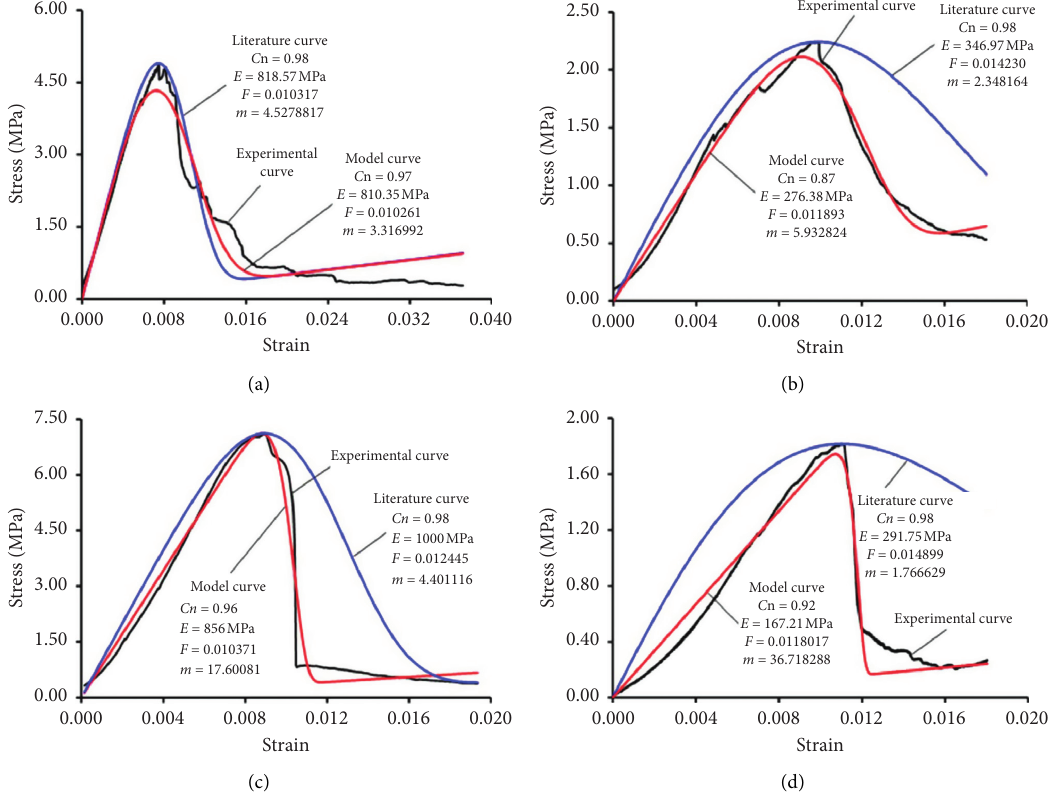
Figure 3: Comparison between experimental curves and theoretical curves: (a) coal sample 1, (b) coal sample 2, (c) coal sample 3, and (d) coal sample